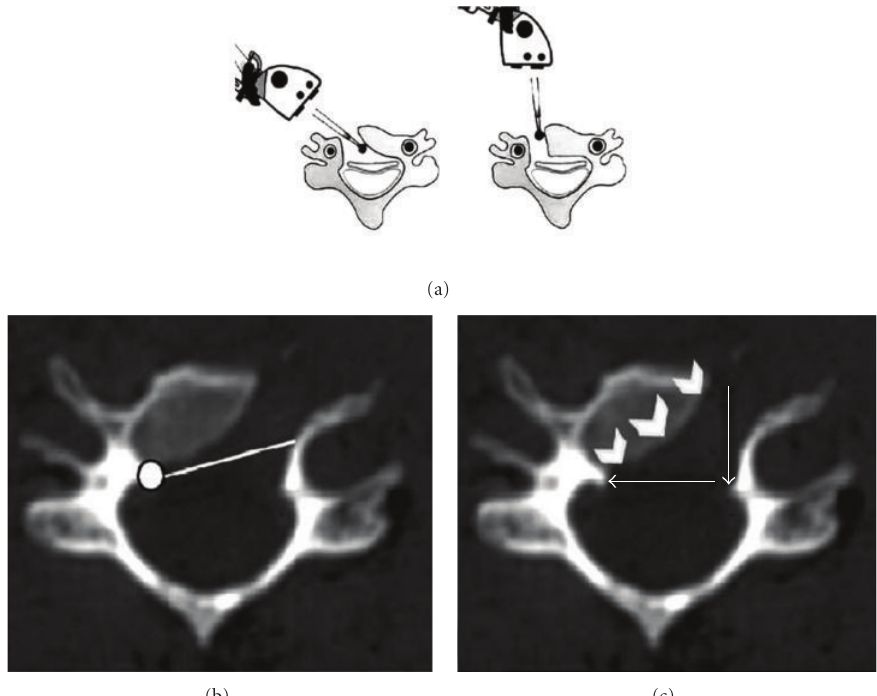
Figure 4: (a) The microscope is first positioned vertically (right picture). The drilling begins vertically, up to the posterior cortical bone, at that time the microscope has to be repositioned to get an oblique view (left picture). The drilling is then continued horizontally up to the contralateral side. (b)-(c) Postoperative axial CT scan showing the directions (white arrows) and final area of drilling.